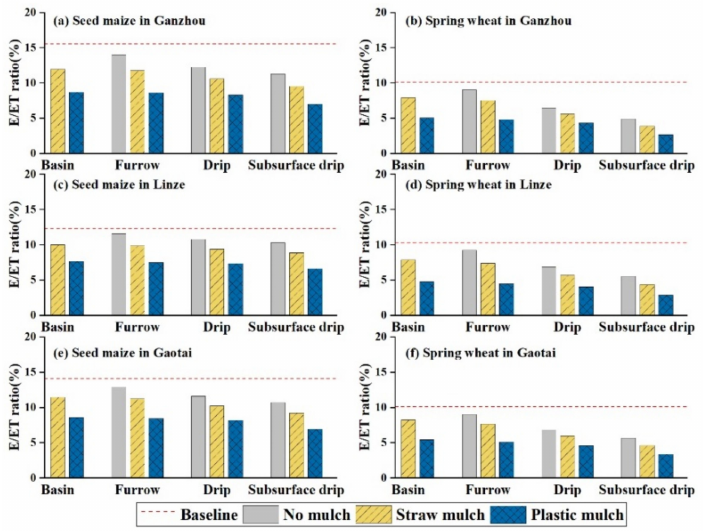
Figure 6. Comparisons of E/ET ratios for seed maize in ( a ) Ganzhou, ( c ) Linze and ( e ) Gaotai, and spring wheat in ( b ) Ganzhou, ( d ) Linze and ( f ) Gaotai under different combinations of management